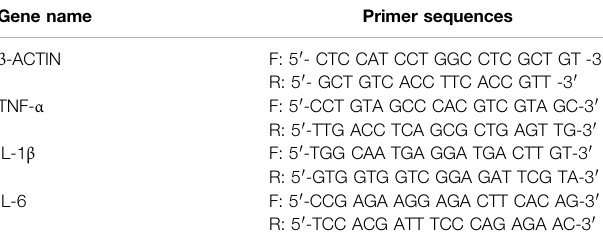
TABLE 1 | Primer sequences used in this study. Gene name Primer